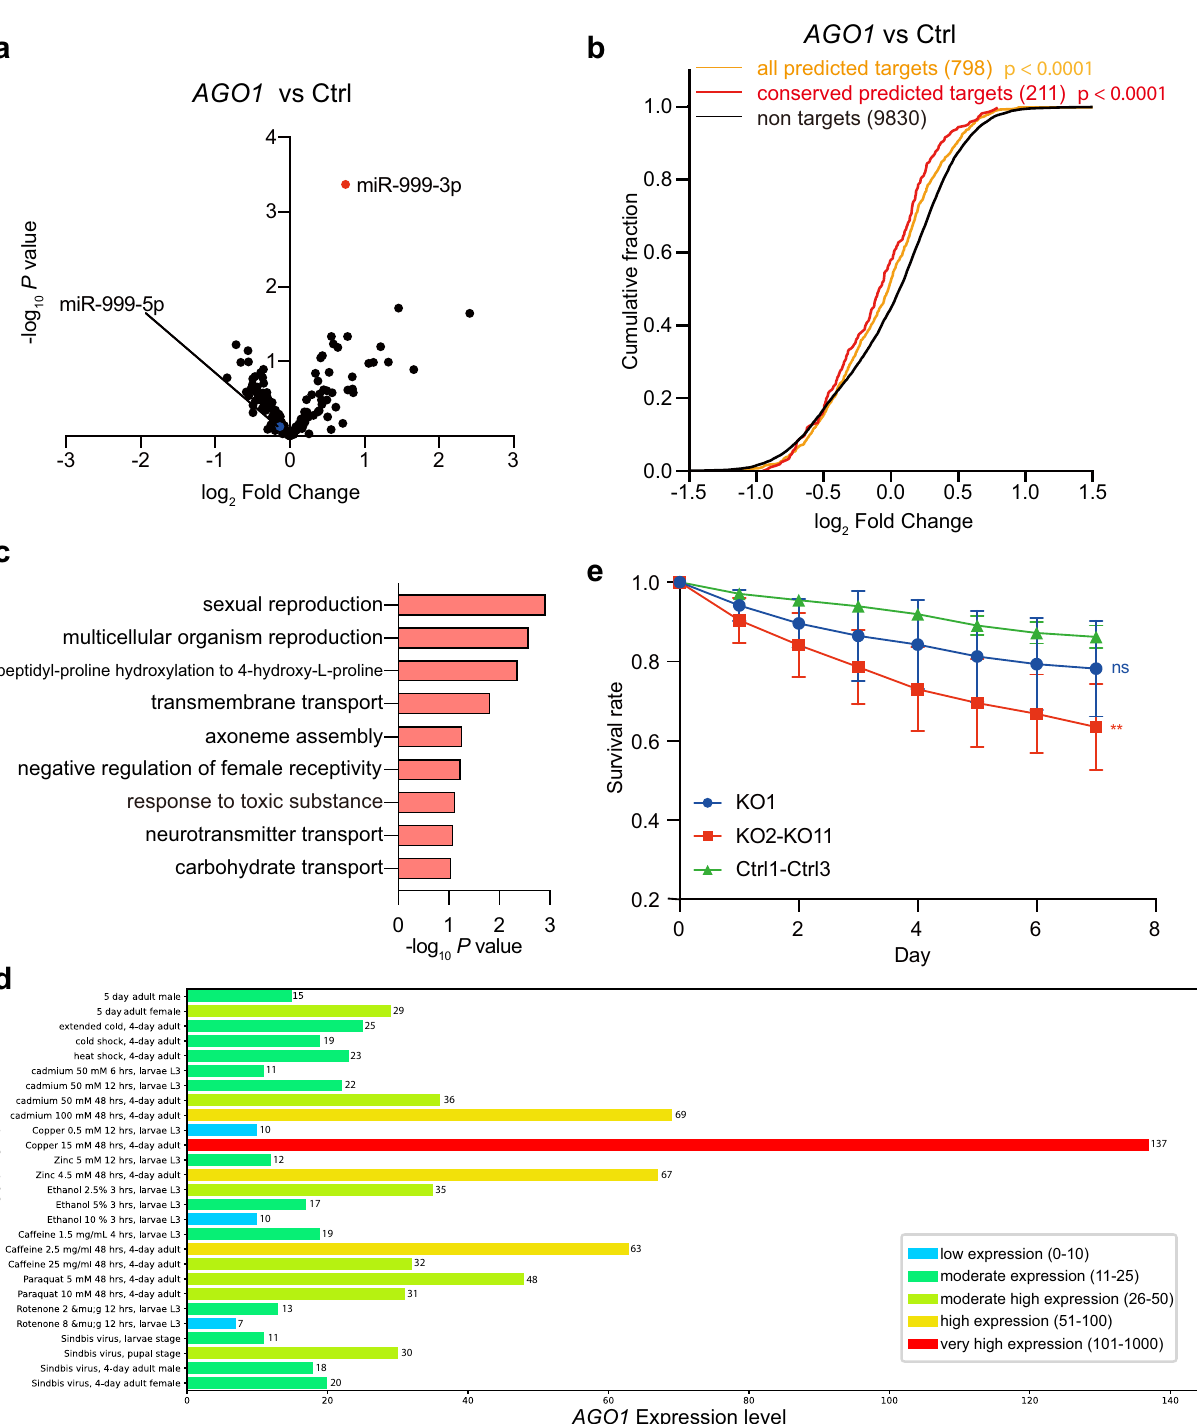
control-KO fl ies. Unadjusted P values were determined for the GO term analysis. d The expression of AGO1 after different treatments were generated by mod- ENCODE of FlyBase. Five-day adult male and female are included to indicate baseline AGO1 expression. e Survival rate for AGO1 trigger KO fl ies after hydrogen peroxide exposure compared with control-KO fl ies. Data are presented as mean± SD. ( ∗∗ ) P =0.0094<0.01, t test. Four independent oxidative stress experiments were conducted. In each experiment, each fl y line has three vials starting with 20 male fl ies. Source data are provided as a Source Data fi